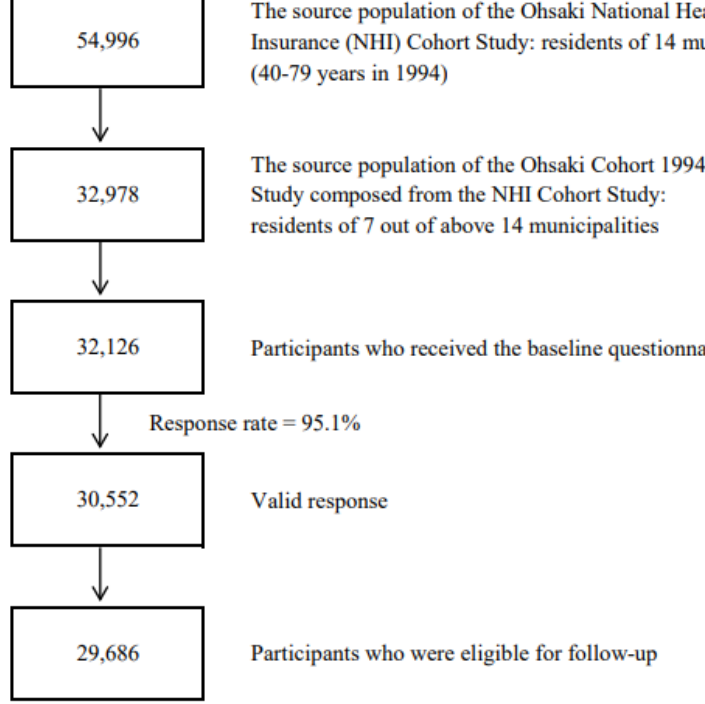
Figure 1. Flowchart of study participants of the Ohsaki Cohort 1994 Study.